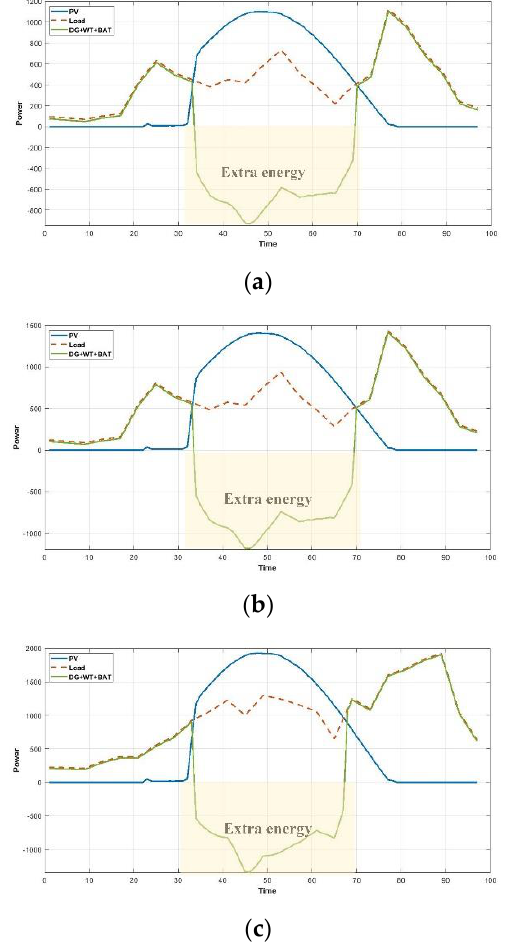
Figure 10. Practical results of the HIMGs: ( a ) MG 1 , ( b ) MG 2 , and ( c ) MG 3.